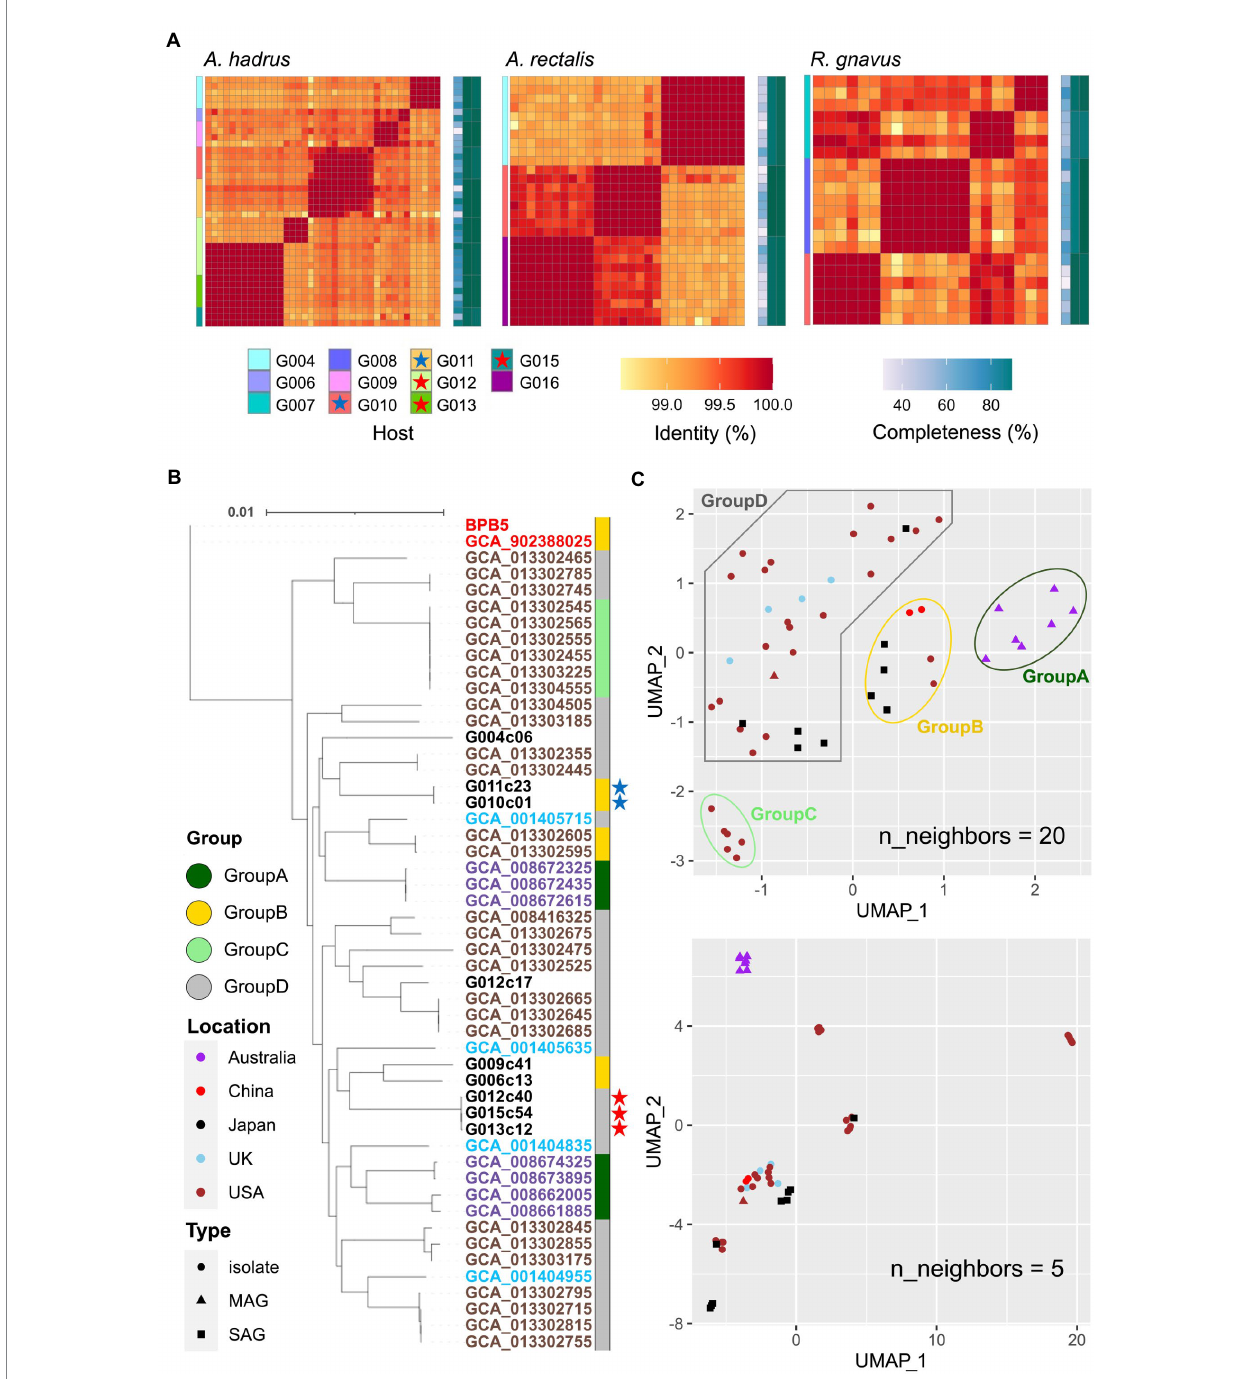
FIGURE 2 Phylogenetic analysis of gut bacterial SAGs for A. hadrus , A. rectalis , and R. gnavus . (A) Heatmaps of average nucleotide identity (ANI) among SAGs of the three species. The tiles on the left indicate the host of obtained SAGs. Colored stars in the host legends indicate cohabitants. Central tiles indicate the ANI between short-read (SR)-SAGs. Tiles on the right represent the completeness of SAGs processed in different steps [left column: raw SR-SAG, middle column: composite short-read SAG (CSR-SAG), right column: composite long-read SAG (LR-SAG)]. As shown in panels B , C , publicly available A. hadrus genomes obtained from isolates or metagenome-assembled genomes (MAG) were compared with our A. hadrus SAGs. (B) A SNP-based tree of A. hadrus genomes based on single nucleotide polymorphisms (SNPs) of the core gene. The label color indicates the country where the A. hadrus genome was obtained. The color strip on the right represents the genome group based on Uniform Manifold Approximation and Projection (UMAP) analysis (C) . The colored stars are closely related SAGs obtained from the cohabitants. (C) UMAP plot of A. hadrus genomes based on the presence of homologous gene groups. The point color indicates the country where the bacterial sample was obtained, and the point shape indicates the data type of genome